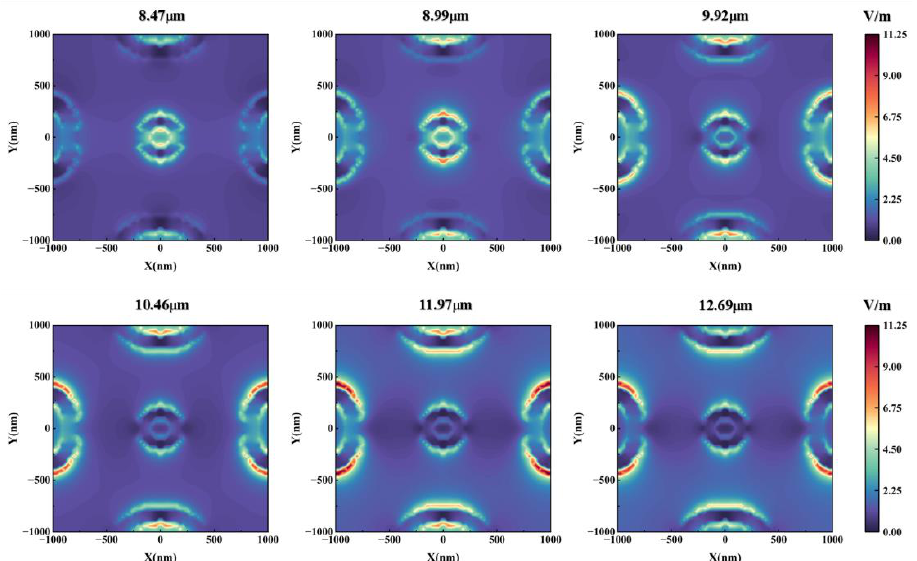
Figure 3. Surface electric field distribution under different wavelengths of incident light (TM wave).